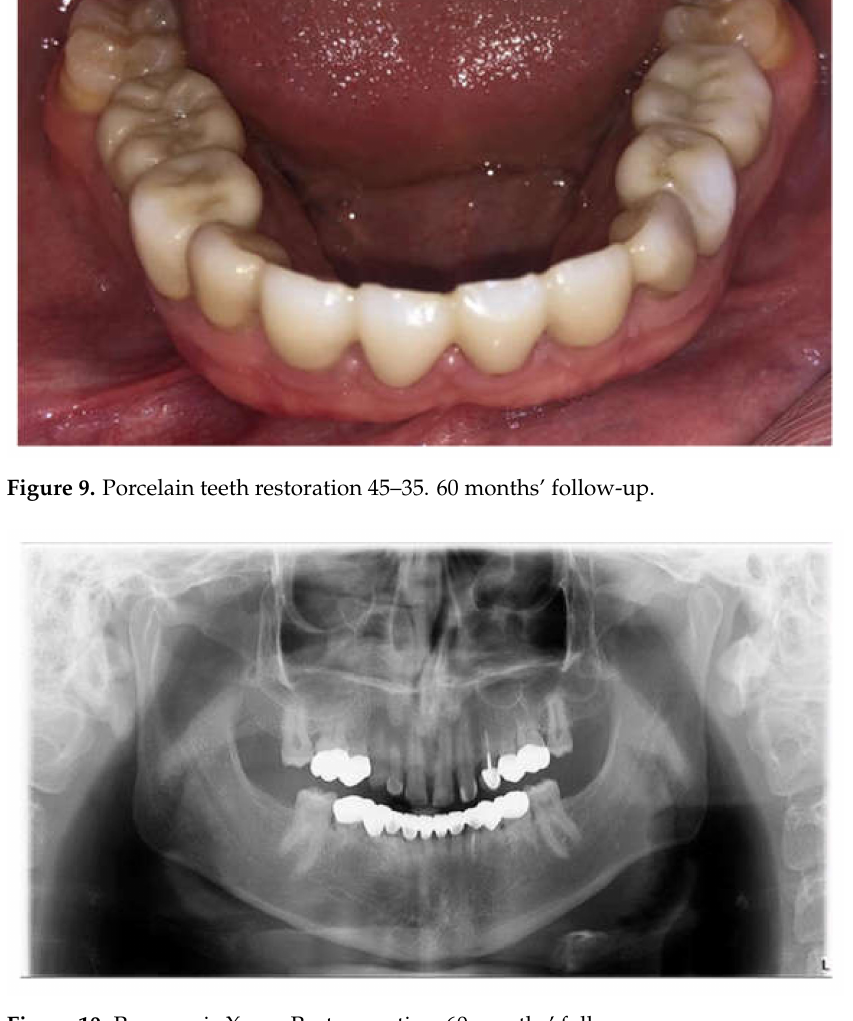
Figure 10. Panoramic X-ray. Post-operative, 60 months’